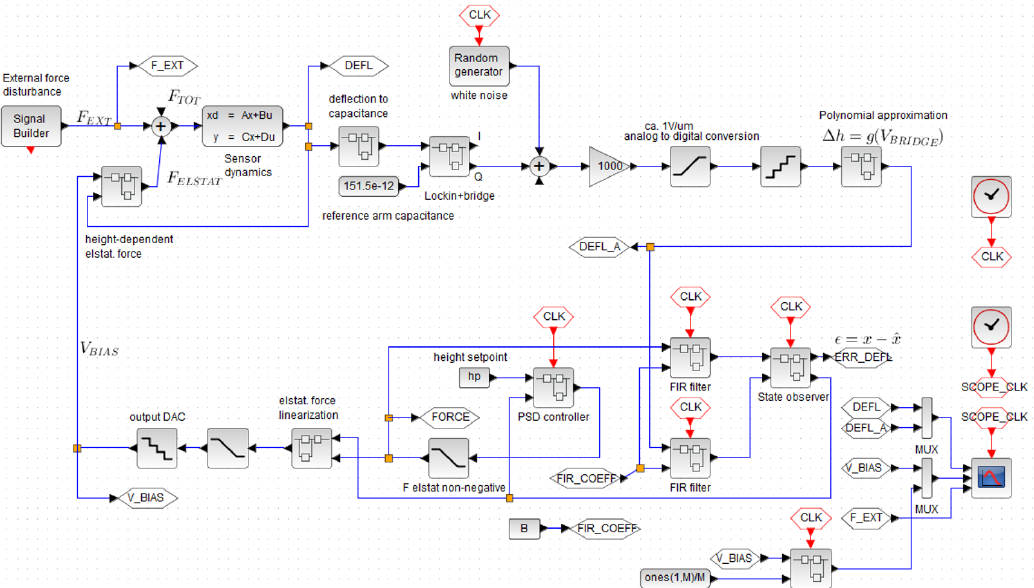
Figure 7. Block diagram of the sensor in a closed loop with the ADRC state feedback controller. The nonlinear electro-mechanical conversion’s effects on both deflection-dependent electrostatic force and capacitance are modeled. The function of synchronous lock-in demodulator is modeled by its behavioral model transforming the capacitance to the DC voltage through the magnitude and angle of the capacitive bridge AC transfer function. At the side of the digital controller, the sources of nonlinearities are modeled by saturation and quantization blocks (see the Supplementary